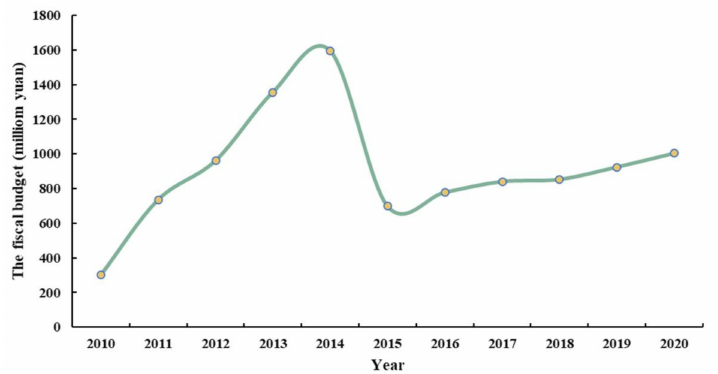
Figure 13. The fiscal budget in Xichuan County from